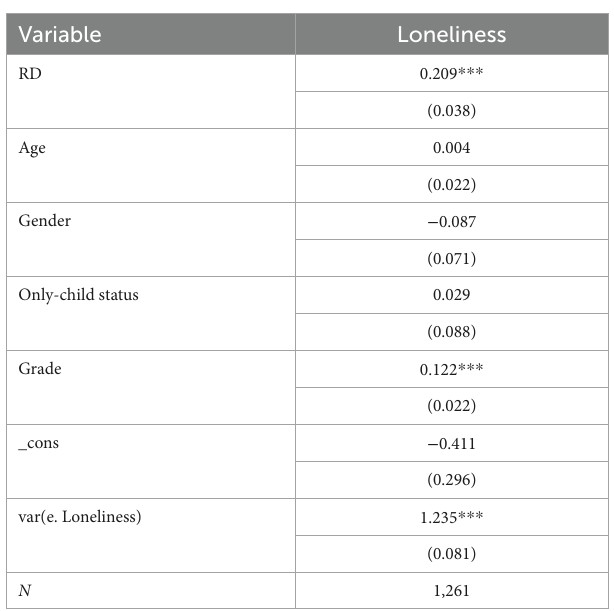
TABLE 5 Robustness test: replacing the econometric model. TABLE 6 Robustness test: narrowing the